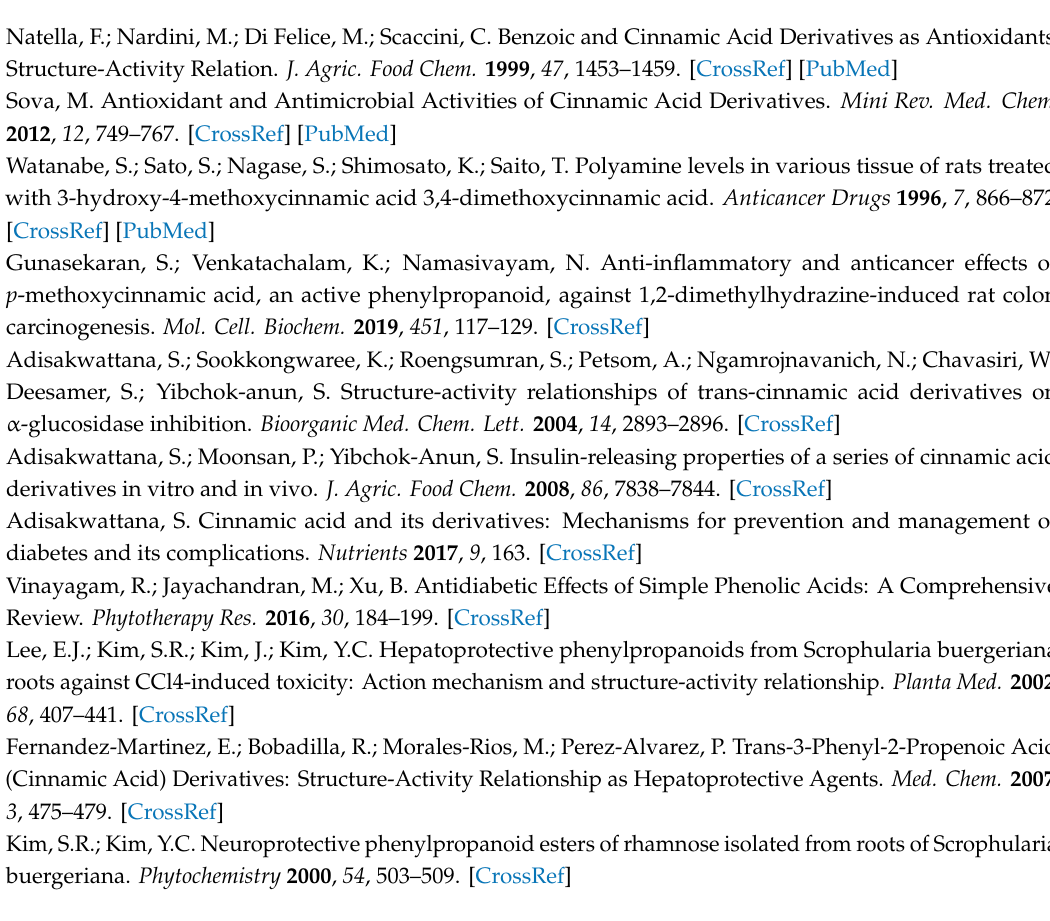
Figure S1: 1 H NMR spectrum of 3,4DMCA-LPC, Figure S2: 13 C NMR spectrum of 3,4DMCA-LPC, Figure S3: 31 P NMR spectrum of 3,4DMCA-LPC, Figure S4: HPLC chromatogram of 3,4DMCA-PC, Figure S5: HPLC chromatogram of 3,4DMCA-LPC, Figure S6: GC chromatogram of fatty acid composition of PC-egg (standard), Figure S7: GC chromatogram of methyl ester of 3,4DMCA (standard), Figure S8: GC chromatogram of fatty acid composition of modified phospholipid fraction PC / LPC, Figure S9: GC chromatogram of fatty acid composition of isolated product of enzymatic reaction of